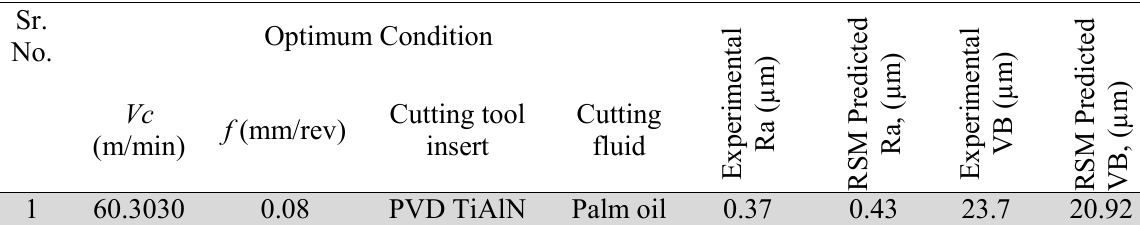
Fig. 15. Response Optimization for Surface roughness (Ra) and flank wear (VB) Confirmation